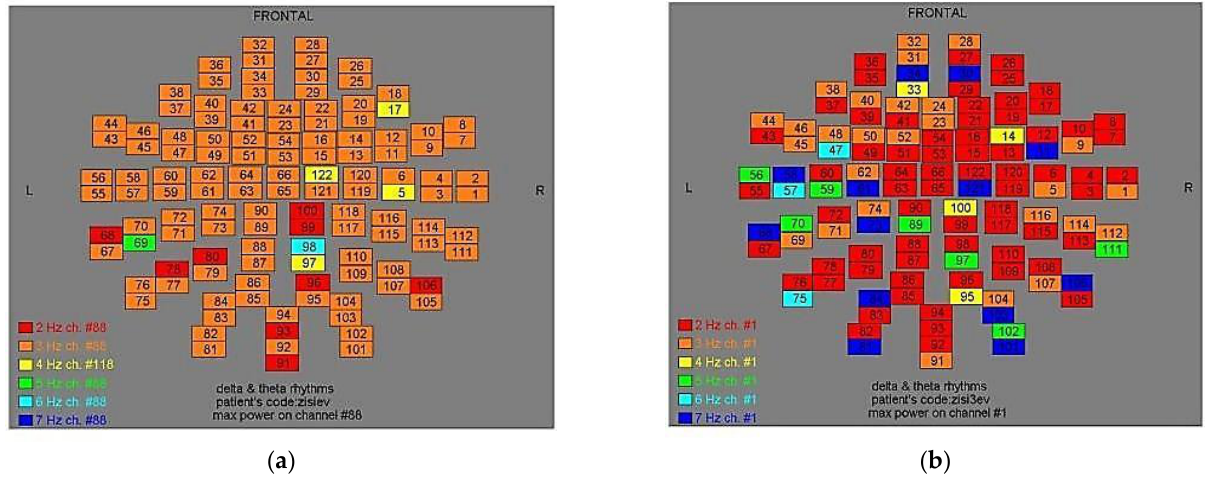
Figure 10. Dominant frequency color mapping for patient #9, before ( a ) and after ( b ) magnetic stimulation .